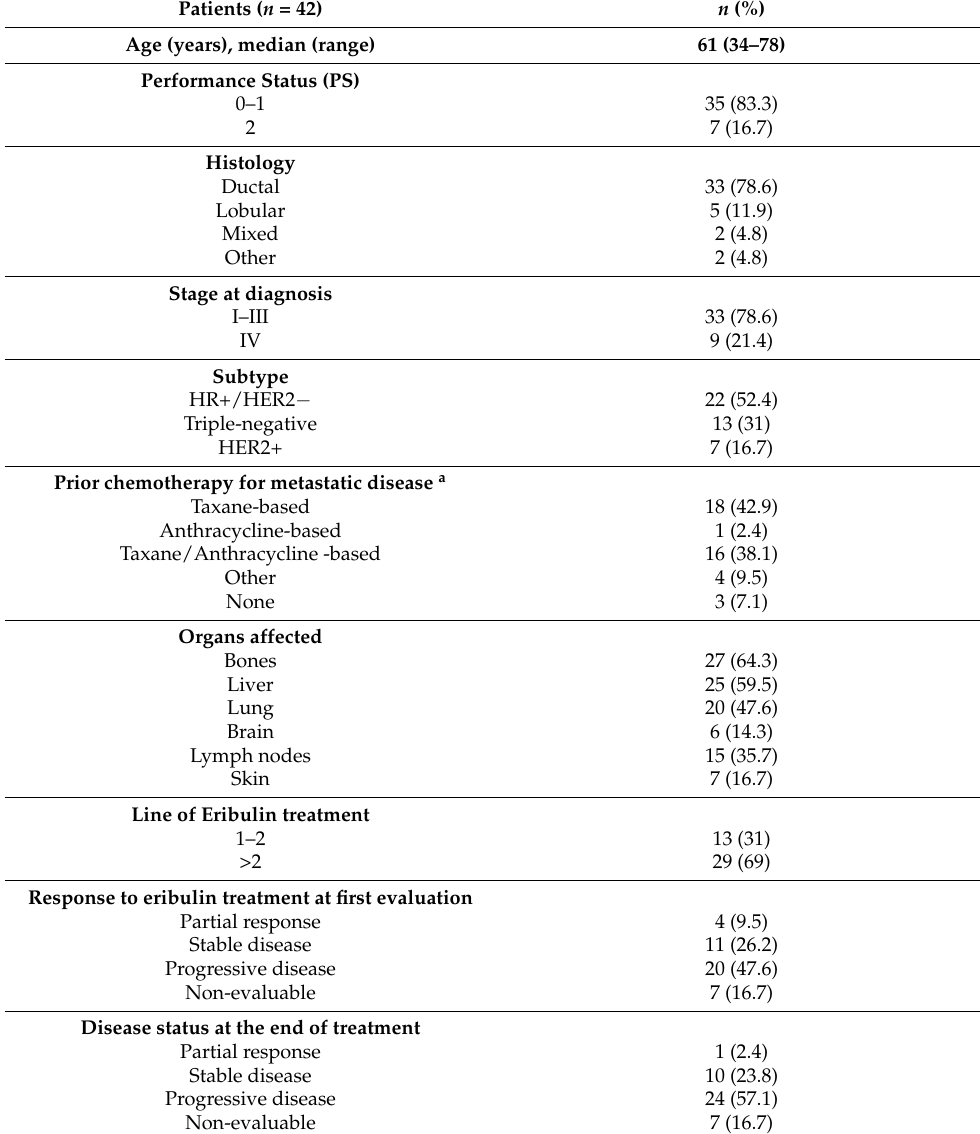
Table 1. Patient and disease characteristics.